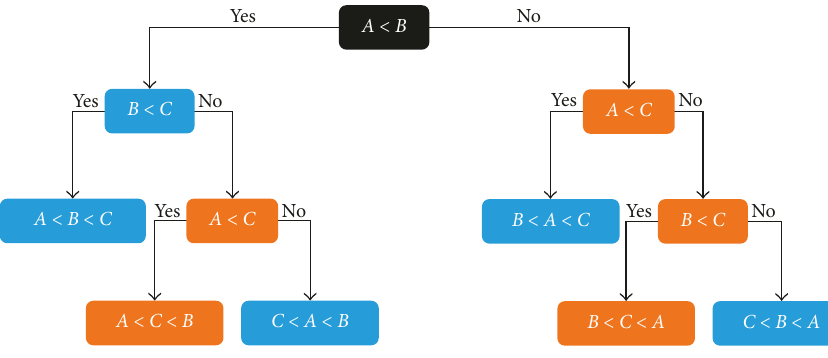
Figure 1: Decision tree concept.